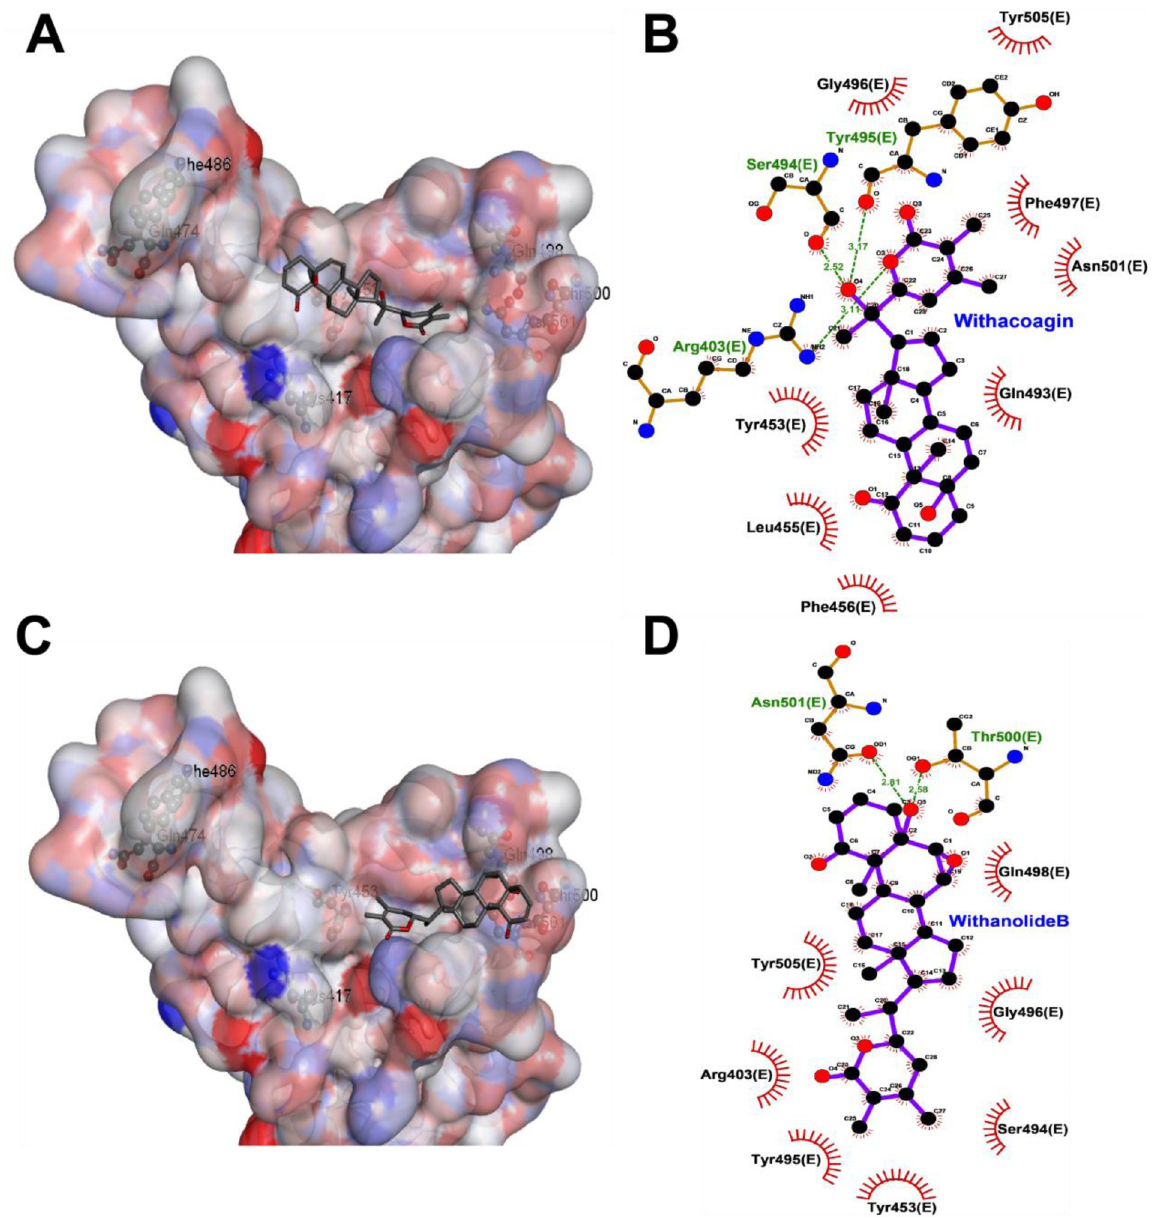
Fig 14. Interaction of (A and B) Withacoagin and (C and D) Withanolide-B with Spike protein: In the left panel the protein is shown in a surface representation colored by atom while the ligand is shown in stick representation. The right panel is a 2D interaction plot of the receptor with the